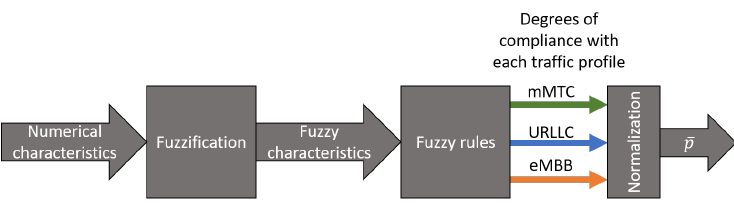
Figure 6. Fuzzy logic controller for application